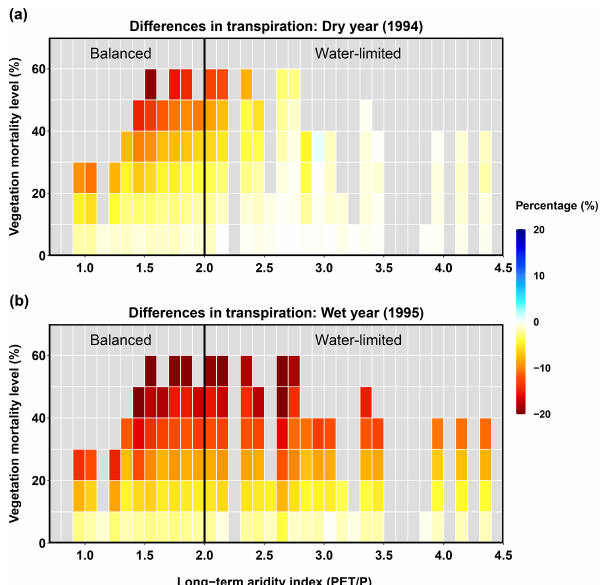
Figure 8. Relationships between long-term aridity, vegetation mor- tality, and difference in transpiration for a dry year (1994, a ) and a wet year (1995, b ).